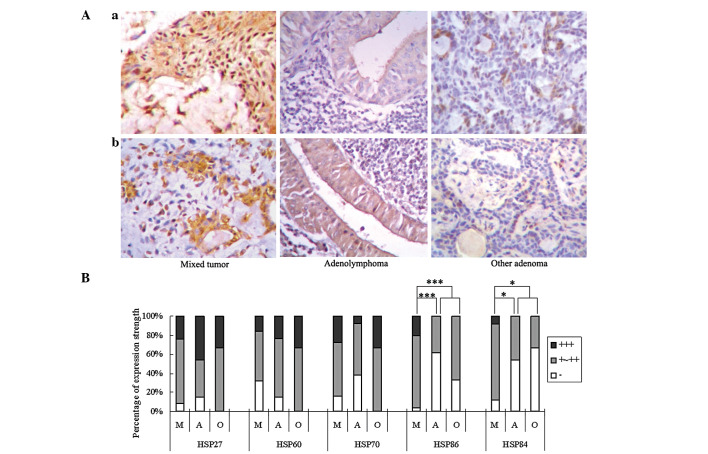
Expression comparison of 5 HSPs in benign types of salivary gland tumor (n=41). (A) Micrograph of expression strength of HSPs. (IHC-SP staining; magnification, ×400). Expression of (a) HSP86 and (b) HSP84 was greater in the mixed tumors, but less in the adenolymphoma and other benign tumor groups. (B) Histogram of expression strength of 5 HSPs. *P<0.05; ***P<0.001. M, mixed tumor; A, adenolymphoma; O, other benign tumors; HSP, heat shock proteins.